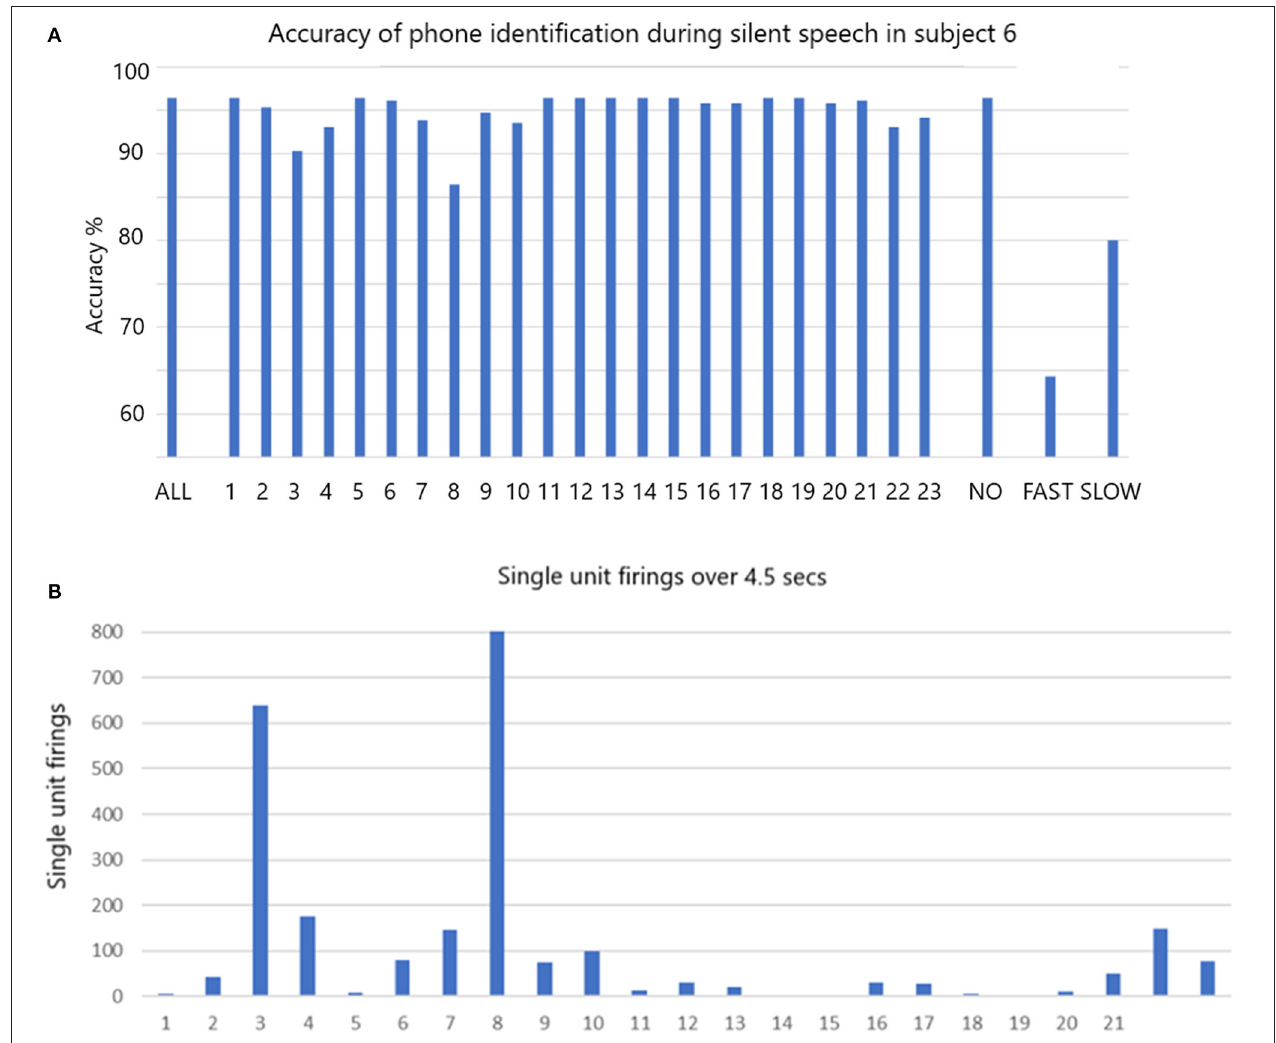
FIGURE 5 | (A) The accuracy of phone identification during silent speech in participant 6 is 96.7% when ALL are included (left bar). Excluding each single unit in sequence may change the accuracy. When the non-firing (NO) are excluded the accuracy remains the same. When FAST firing are excluded the accuracy drops as shown. When the slow firing are excluded the accuracy also drops as shown. The fine Gaussian SVM was used for this analysis. (B) The total number of firing for all is shown over the whole session that lasted